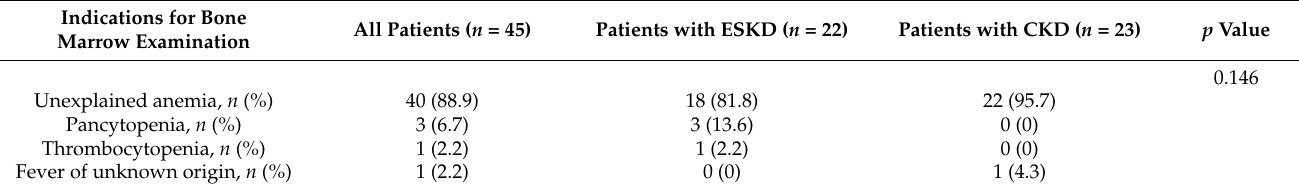
Table 2. Indications for bone marrow examination, stratified by renal function as ESKD or CKD ( n = 45). Indications for Bone All Patients ( n = 45) Patients with ESKD ( n = Marrow Examination